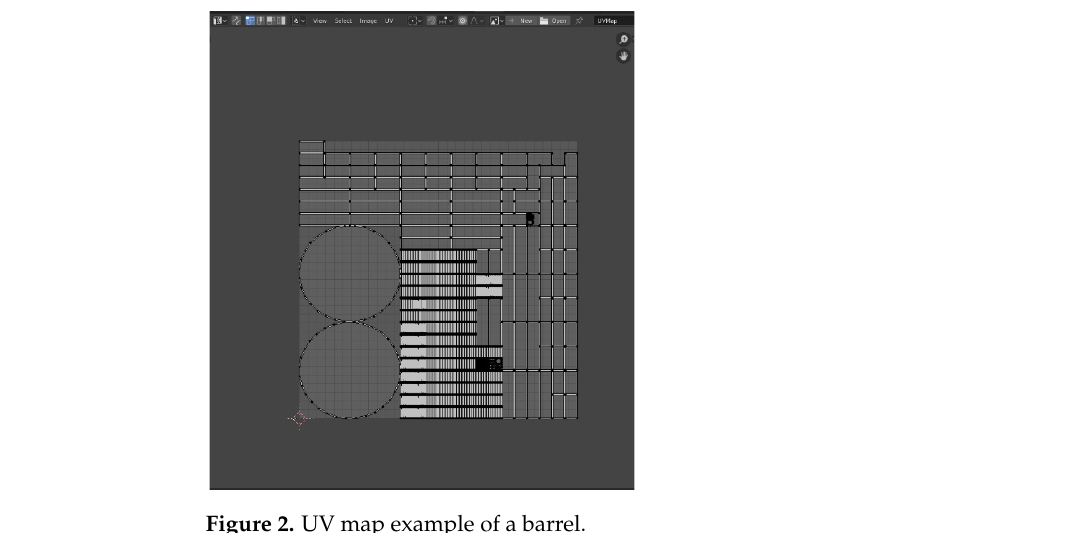
Figure 2. UV map example of a barrel.